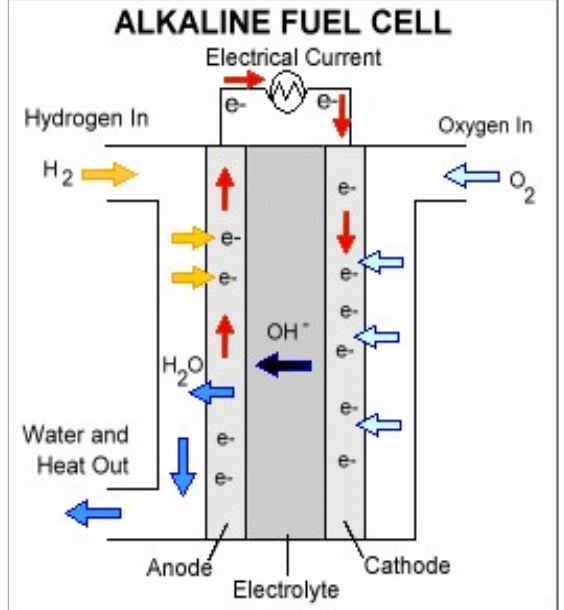
Figure 5. Schematic representation of alkaline fuel cells [41]. Reproduced with permission from Vaghari et al. (2013), ©Springer, 2013 (open access—Creative common attribution 2.0).